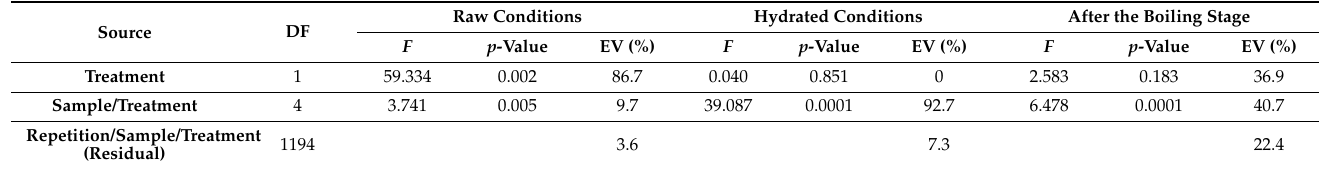
Table 1. Analysis of variance for Type of treatment , Sample within treatment , and Residual for cell walls, with regard to raw conditions, hydrated conditions, and after the boiling stage.